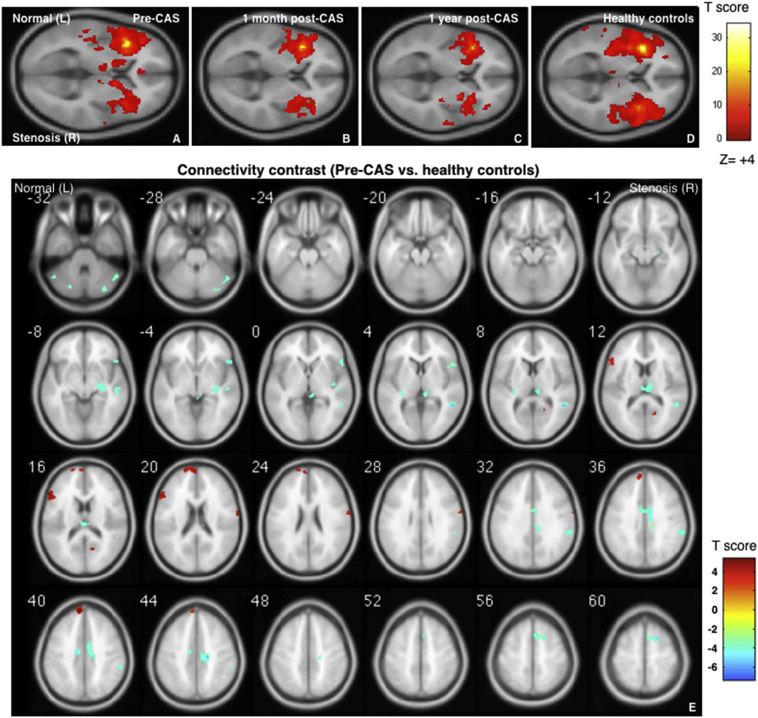
Group-level functional connectivity maps in the salience network (SAL). Four sets of one-sample SAL, seed at left insula (ISL) [−38 20 4], radius = 4, family-wise error p < .05. From left to right: carotid stenosis patients before carotid artery stenting (CAS) (A), 1 month after CAS (B), 1 year after CAS (C), and healthy controls (HC) (D). Two-sample contrast map (Pre-CAS > HC) with AlphaSim corrected p < .05. Red blobs show hyper-connectivity and blue blobs show hypo-connectivity (E). (For interpretation of the references to color in this figure legend, the reader is referred to the web version of this article.)